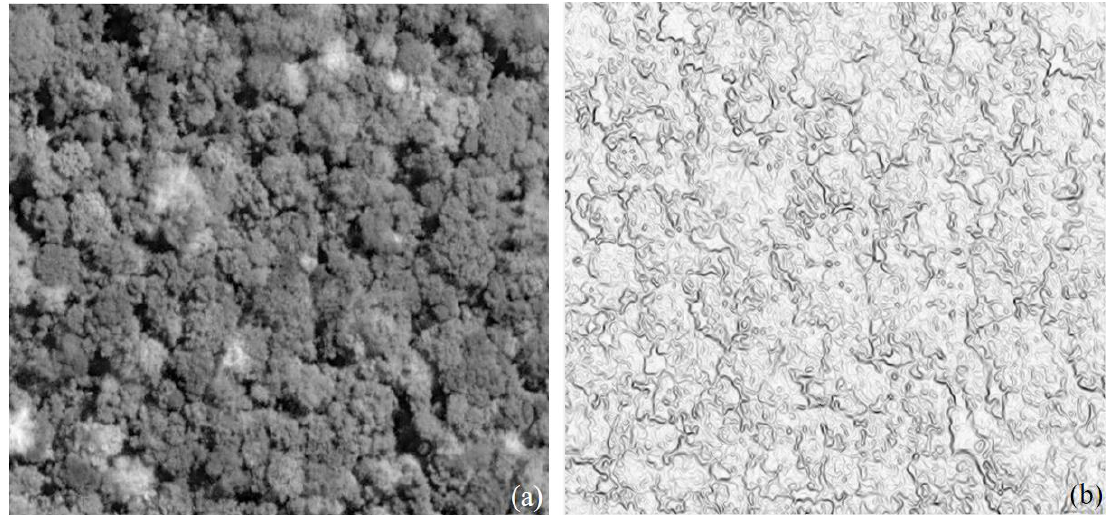
Figure 3. The first principle component (PC1) ( a ) and inverse gradient image ( b ).